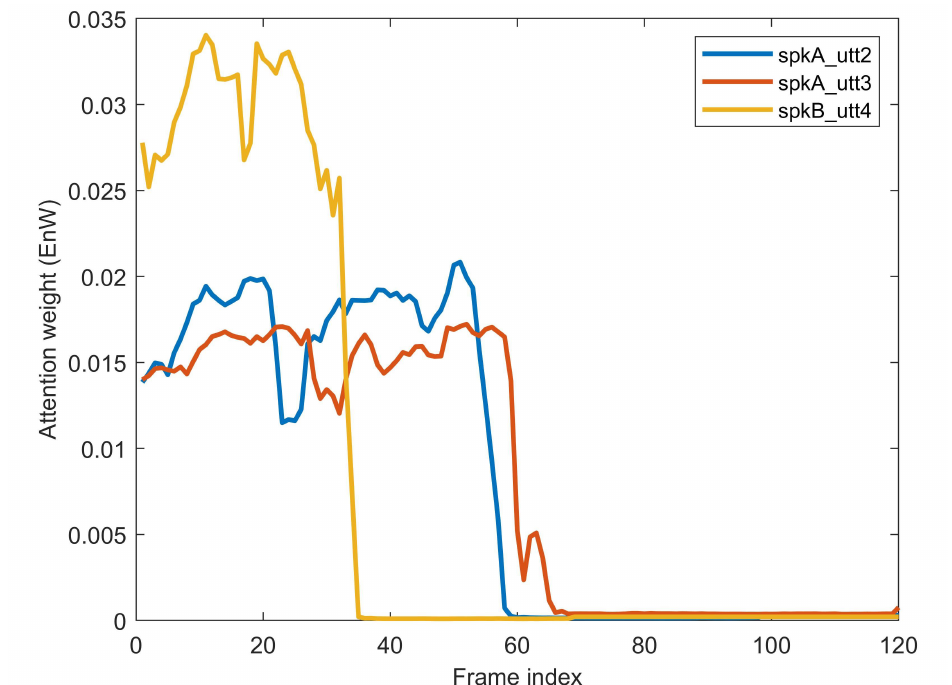
Figure 7. An illustrative example of the attention weight EnW . The physical length of the enrollment Spk _ utt 1 is 120